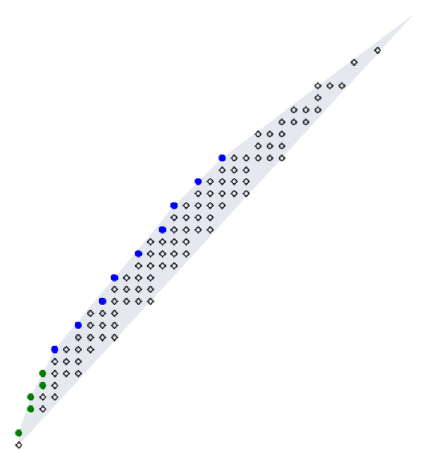
Figure 25 . Newton polygon for diag(3 ; 3 ; 4)